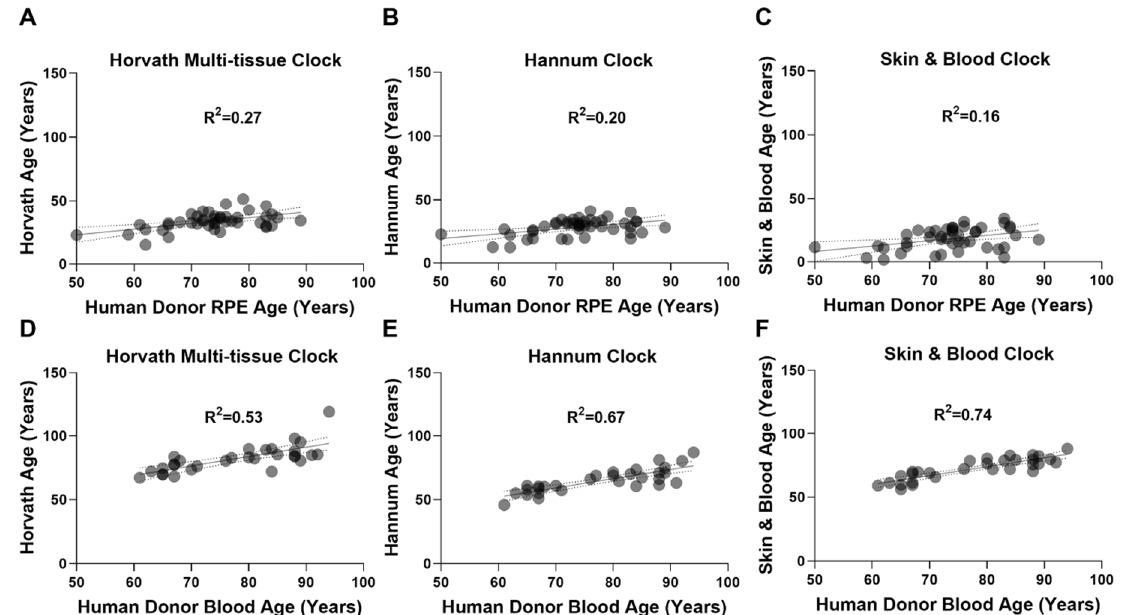
Figure 1. Epigenetic clocks perform poorly in RPE. Linear regressions of estimated DNAm age (years) with chronological age (years) were performed on ( A – C ) RPE ( n = 44) and ( D – F ) whole blood-derived ( n = 30) gDNA samples, to assess the performance of ( A , D ) Horvath’s multi-tissue clock, ( B , E ) Hannum’s clock, and ( C , F ) the Skin & Blood clock. ( A – C ) In RPE gDNA, linear regressions of DNAm age estimation with chronological age are shown for: ( A ) Horvath’s multi-tissue clock (R 2 = 0.27); ( B ) Hannum’s clock (R 2 = 0.20); and ( C ) Skin & Blood clock (R 2 = 0.16). All demonstrated poor clock performance and weak correlations. In whole blood-derived gDNA, linear regressions of DNAm age estimation with chronological age for ( D ) Horvath’s multi tissue clock (R 2 = 0.53), ( E ) Hannum’s clock (R 2 = 0.67), and the ( F ) Skin & Blood clock (R 2 = 0.74) demonstrated improved performance with the Skin & Blood clock showing the most accurate predictions.